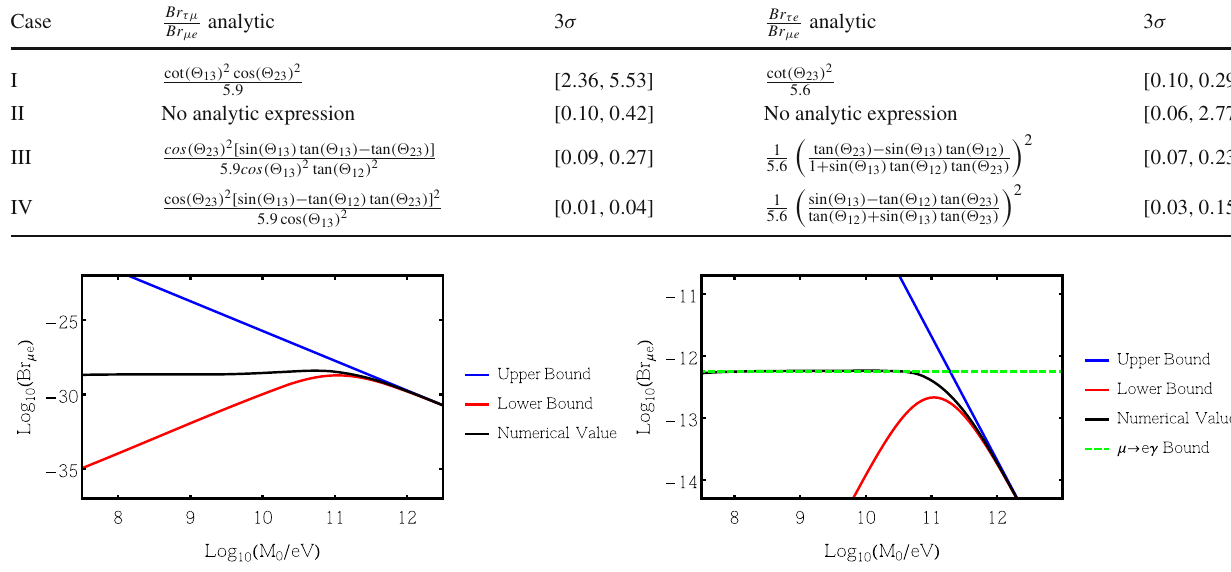
(cid:21) = 10 − 9 . For the configuration in the right panel the branching ratio Fig. 4 Upper bound (upper line), lower bound (lower line) and numer- icallyobtainedvalue(intermediateline)for Br μ e areplottedagainst M 0 is close to the experimental bound (dotted line). The numerically esti- mated value lies always between the two bounds, has a maximum near for two different configurations of ( q , y ,(cid:9)) : the left panel shows the , π ) and the right panel for ((cid:21), π , π ) with M 0 = m W and seems to approach a constant value for M 0 < m branching ratio for ( 0 . 1 , π 3 6 3 6